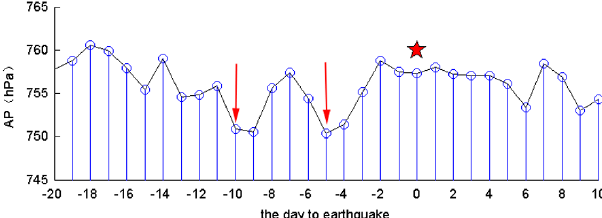
Fig. 10. Air pressure variation at the mountain point 30 ◦ N, 102.5 ◦ E before and after the event (red star points to the day in which earth- quake happened).